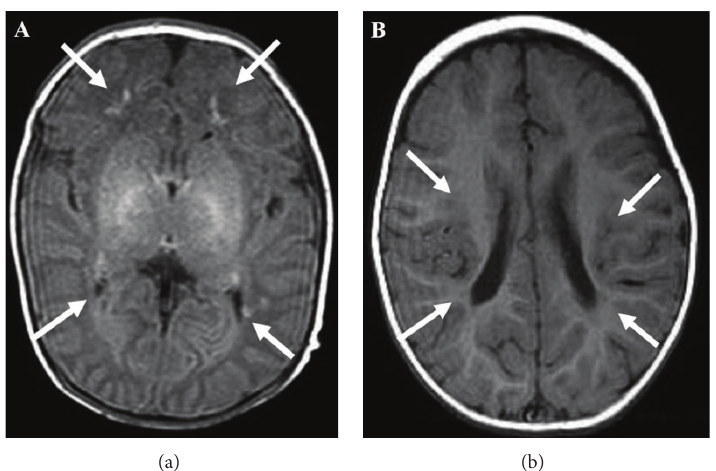
Figure 2: Brain MRI. Newborn with classic adrenal congenital hyperplasia, on day 12 after birth, white matter abnormalities that consisted of bilateral small diffuse hyperintensities (white arrow) are depicted on T1-weighted images (a). At 1yr. of age, bilateral small diffuse hyperintensities are documented (white arrow) on T1-weighted images (b). (Reprinted with permission from [49], Copyright Japanese Society for Pediatric